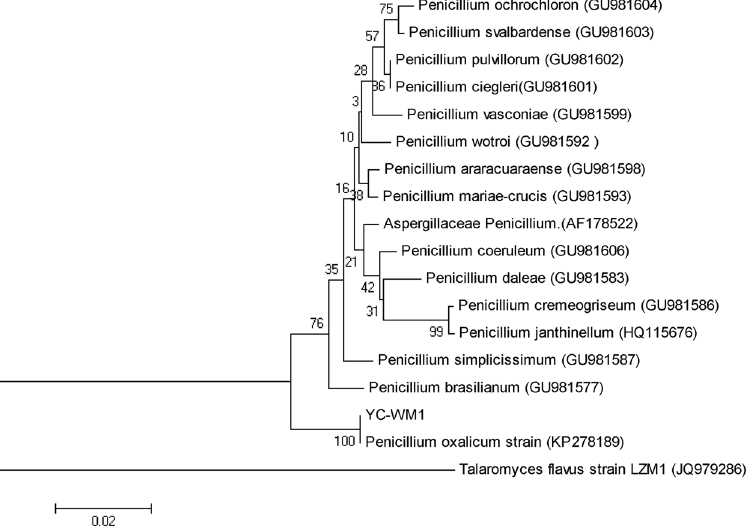
Figure 1. Phylogenetic tree based on ITS sequences of YC-WM1 and relevant strains. The GenBank accession numbers for each microorganism employed in the analysis were shown behind the species name. The scale bar indicated 0.001 substitutions per nucleotide position. Bootstrap values obtained with 1000 resamplings were indicated as percentages at all branches. Talaromyces flavus strain 1 was a fungus reported with the capable of degrading